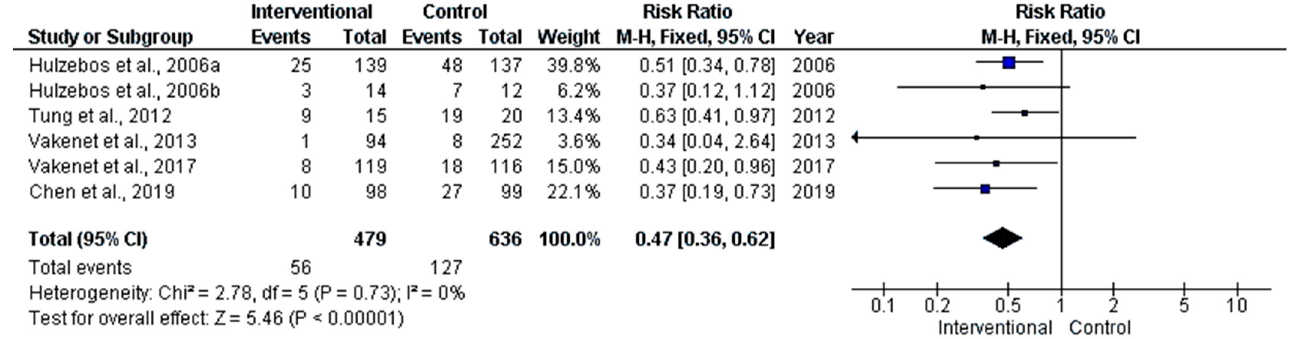
Figure 8. Forest plot evaluating Pi-max in the included studies.